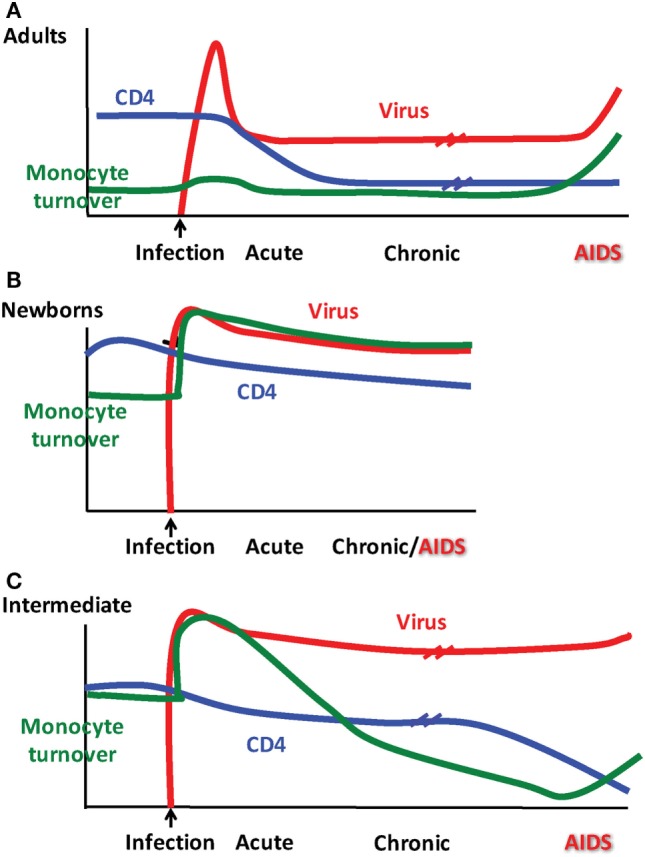
Patterns observed for monocyte turnover, CD4 T cell counts and simian immunodeficiency virus (SIV) infection differ depending on age at infection. Results from Kuroda and colleagues showing monocyte turnover determined by quantification of bromodeoxyuridine (BrdU) incorporation by flow cytometry in monocytes at 24 h post-BrdU intravenous injection, CD4 T cell count obtained by peripheral blood cellular immunophenotyping via flow cytometry in conjunction with complete blood count (CBC), and SIV RNA plasma viremia as determined by quantitative PCR. Distinct patterns emerged for clinical progression of SIV in rhesus macaques illustrated in (A) adults, (B) newborns, and (C) as what we refer to as an “intermediate” phenotype in older infants infected at ~3–4 months of age.